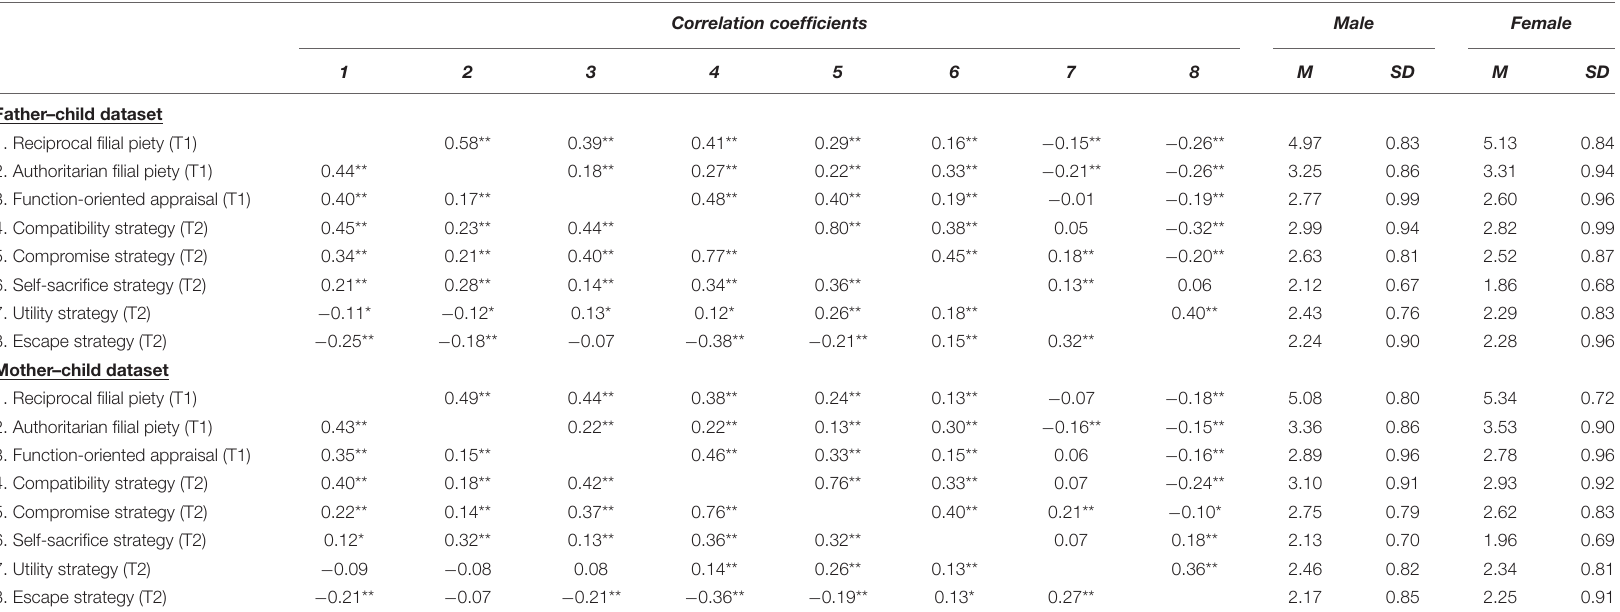
TABLE 2 | Correlations, means, and standard deviations of the main variables in Study 2. Correlation coefficients Male